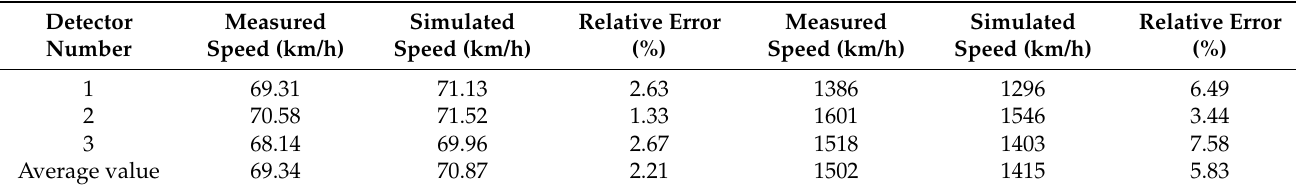
Table 1. Verification results of simulation model in free flow state.